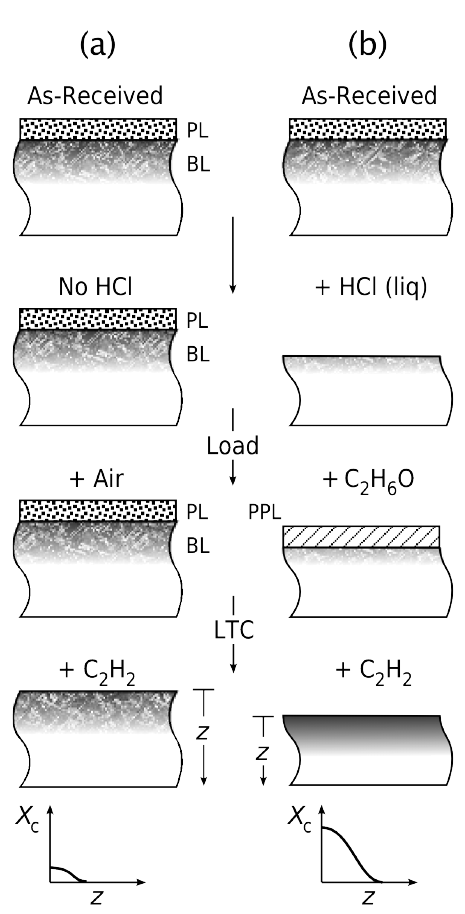
Figure 5. Schematic showing the structuring of AISI-AL-6XN in various stages. ( a ) Direct low-temperature carburization of the as-received alloy, featuring a passivating oxide layer and a Beilby layer. C 2 H 2 (acetylene), the carburizing gas, removes the passivating oxide layer, but does not etch the alloy. The Beilby layer acts as a carbon diffusion barrier, resulting in an underdeveloped (or nonexisting) carbon-fraction–depth profile X C [ z ] . ( b ) Etching in concentrated aqueous HCl removes the passivating oxide layer and the Beilby layer. Storing in C 2 H 5 OH and drying in N 2 (on moving into the gas furnace) results in a provisional passivating layer. Low-temperature carburization with C 2 H 2 readily removes the provisional passivating layer to generate a fully-developed X C [ z ]